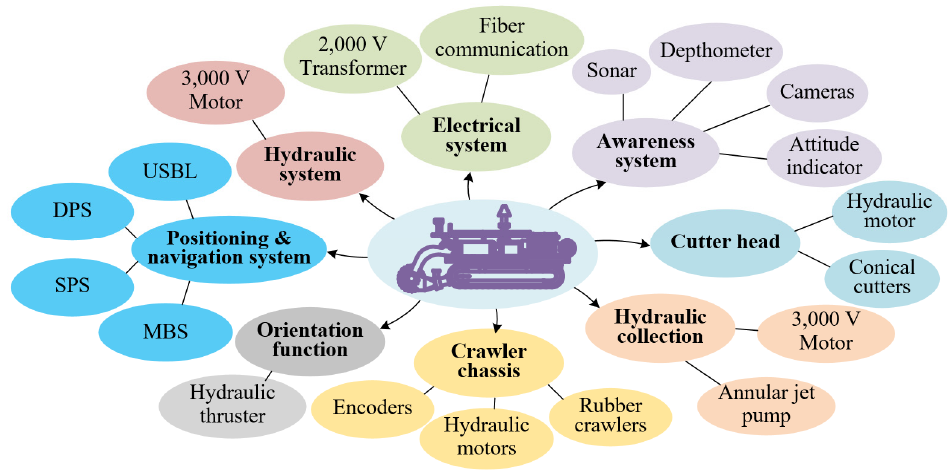
Figure 8. Vehicle components.